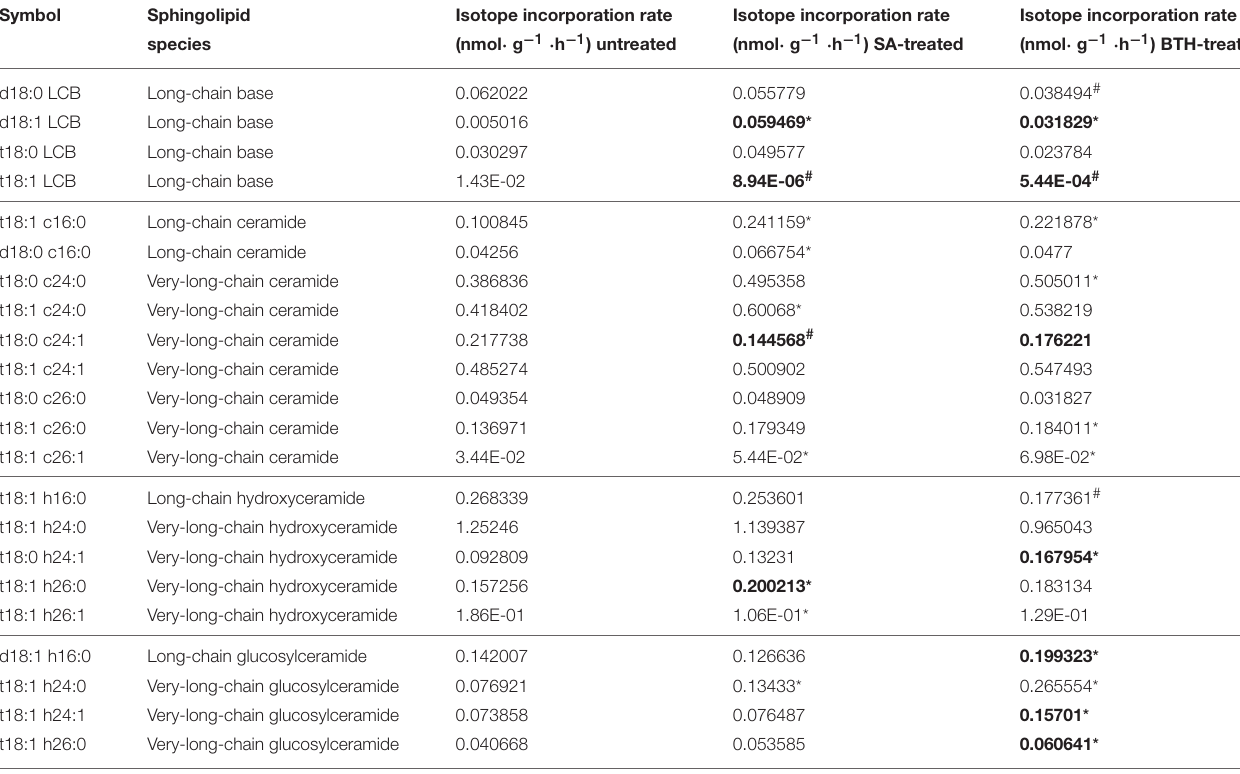
TABLE 2 | Isotopic incorporation rate for major sphingolipids, with or without 100 µ M SA or 100 µ M BTH treatments. Symbol Sphingolipid Isotope incorporation rate Isotope incorporation rate Isotope incorporation